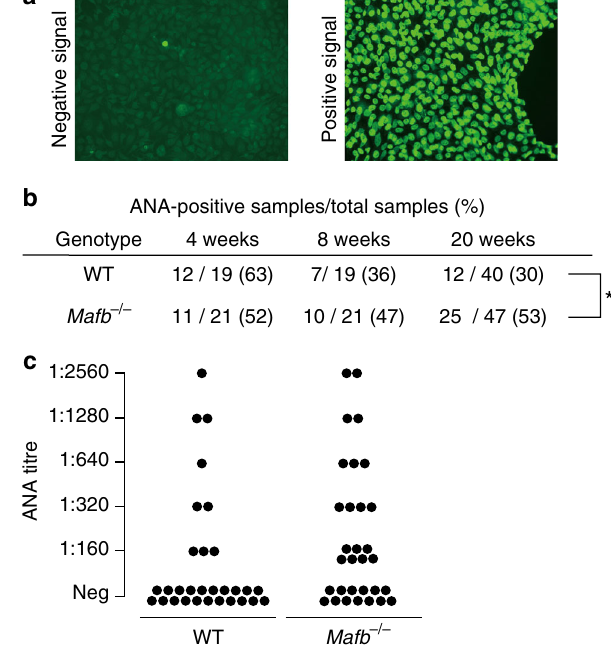
mice with an ANA titer (range: 1:160 – 1:2560) was signi fi cantly higher compared with WT mice ( p < 0.05, Fisher ’ s exact test). b , c Data from two to four independent experiments were